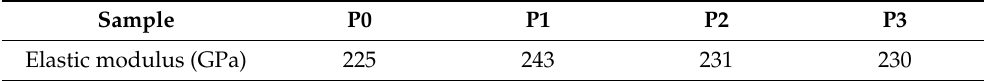
Figure 15. Load-displacement curves of coatings fabricated with different ultrasonic vibration power. Table 3. Elastic modulus of coatings fabricated with different ultrasonic vibration power.